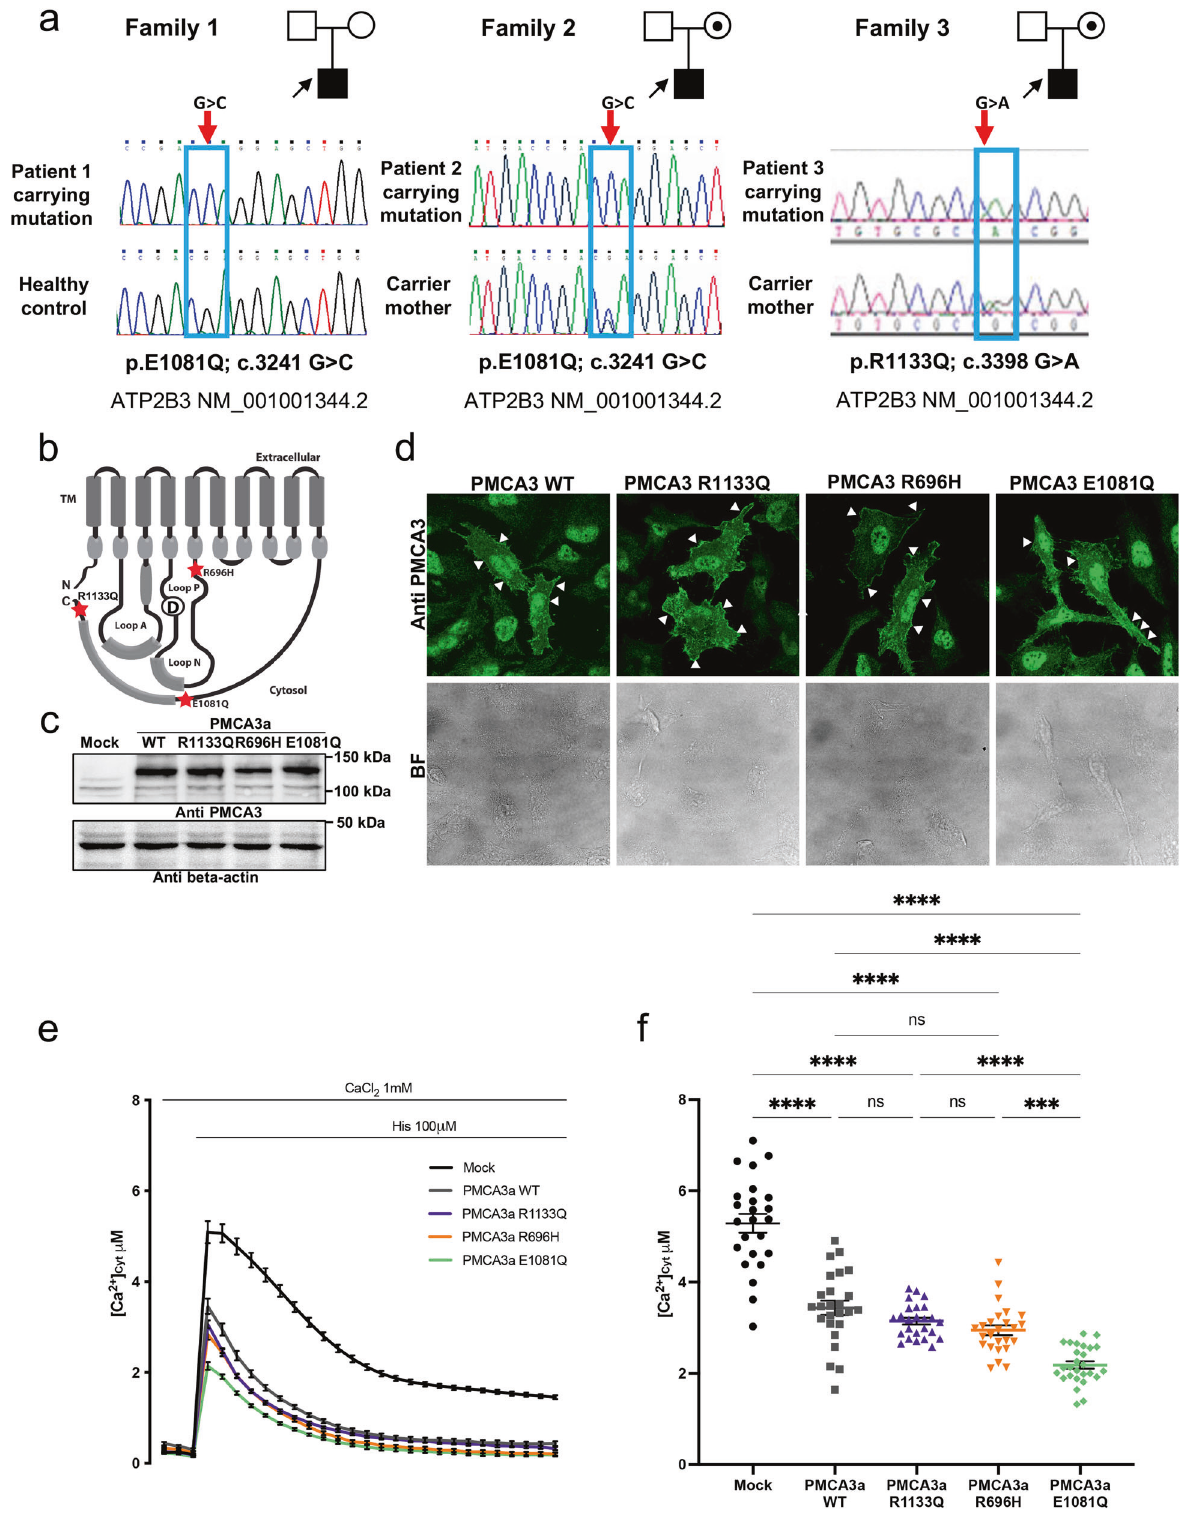
Fig. 1 Analysis of the human exogenous pump mutants overexpressed in model HeLa cells and cytosolic Ca 2 + measurements. a Pedigree of the families with three affected males suggesting X-linked inheritance in family 2 and 3; Sanger sequencing chromatograms showing PMCA3 mutations in the patients and control subjects. b Schematic representation of PMCA topology with selected point mutations position marked with a red star. c Western blotting and d immunocytochemistry, analysis showing the expression level and cellular localization of the wild type and mutated PMCA3. The PMCA3 was revealed by the rabbit polyclonal anti-PMCA3 antibody. e Cytosolic Ca 2 + transients recorded following 100 μ M histamine stimulation of HeLa cells overexpressing the cytAEQ either alone or along with the wt or the mutants PMCA3a pump. f Average peak [Ca 2 + ] values measured upon stimulation (bars represent mean μ M ± SEM). ***, p < 0,001; ****, p < 0.0001: ns, not signi fi cant. The numbers on the dots indicate the number of independent measurements out of three independent transfections. Cell Death and Disease (2022)